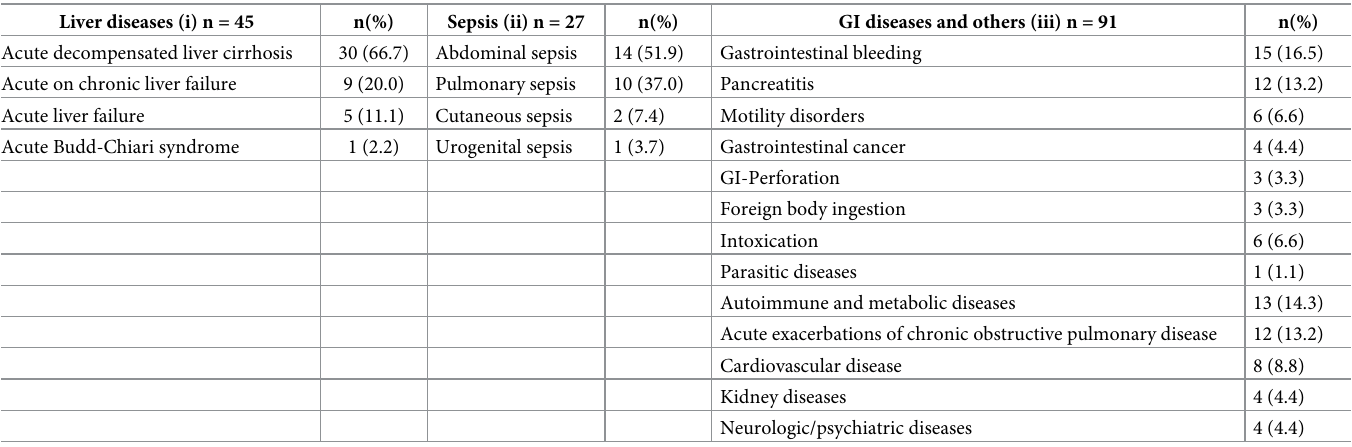
List of diseases of patients in subgroups i (liver diseases), ii (sepsis), and iii (GI diseases and others). Sepsis was defined according to The Third International Consensus Definitions for Sepsis and Septic Shock (Sepsis-3)